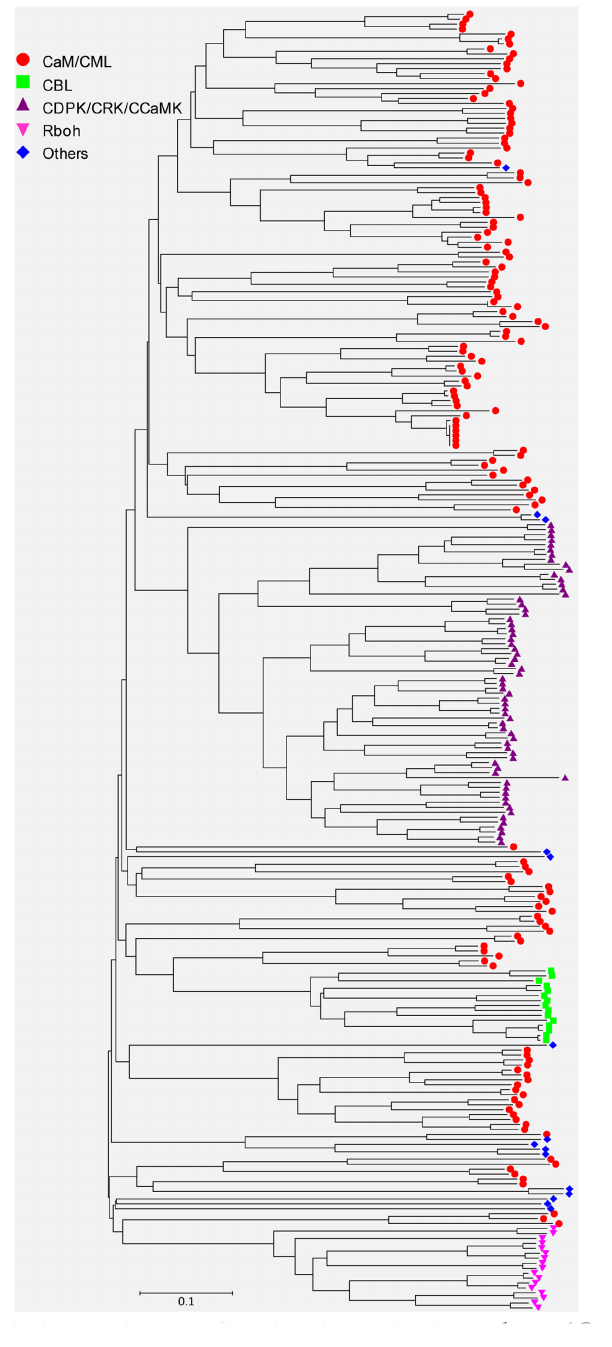
FIGURE 3 | Unrooted phylogenetic tree of EF-hand proteins in soybean ( Glycine max ). The alignment for the phylogenetic tree was performed with ClustalW using full-length amino acid sequences. The phylogenetic tree was created with the MEGA6 software and the neighbor-joining method with 1,000 bootstrap replications. All the 150 CaM/CML proteins are marked with red circles, 15 CBL proteins are marked with green squares, 65 CDPK/CRK/CCaMK proteins are marked with purple triangles, 17 Rboh proteins are marked with pink inverted triangles, and 15 UEPs are marked with blue diamonds. The bar indicates the relative divergence of the sequences